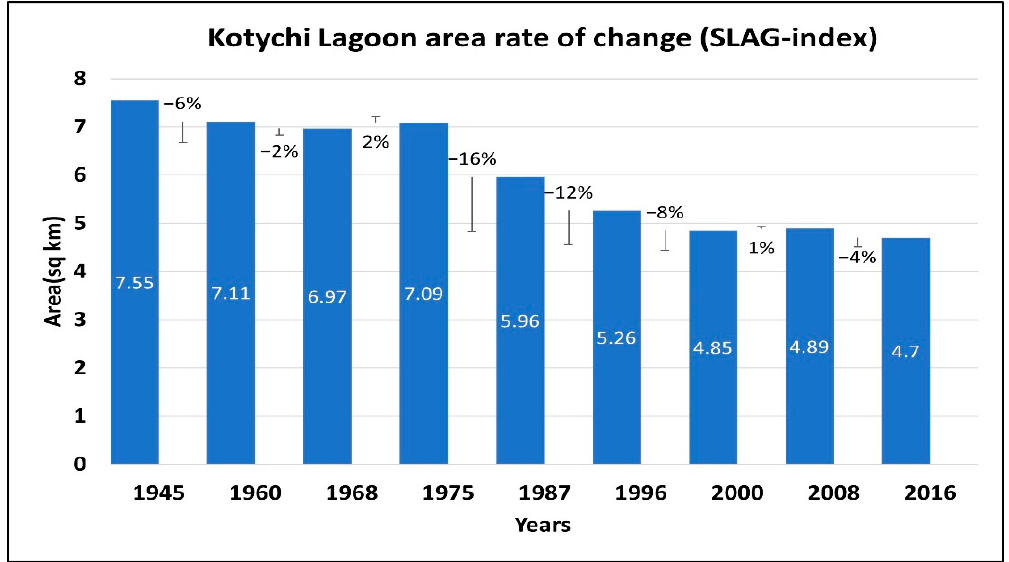
Figure 7. Number of inlets (CMAR-index) diachronically discharging their water into the Kotychi Lagoon.